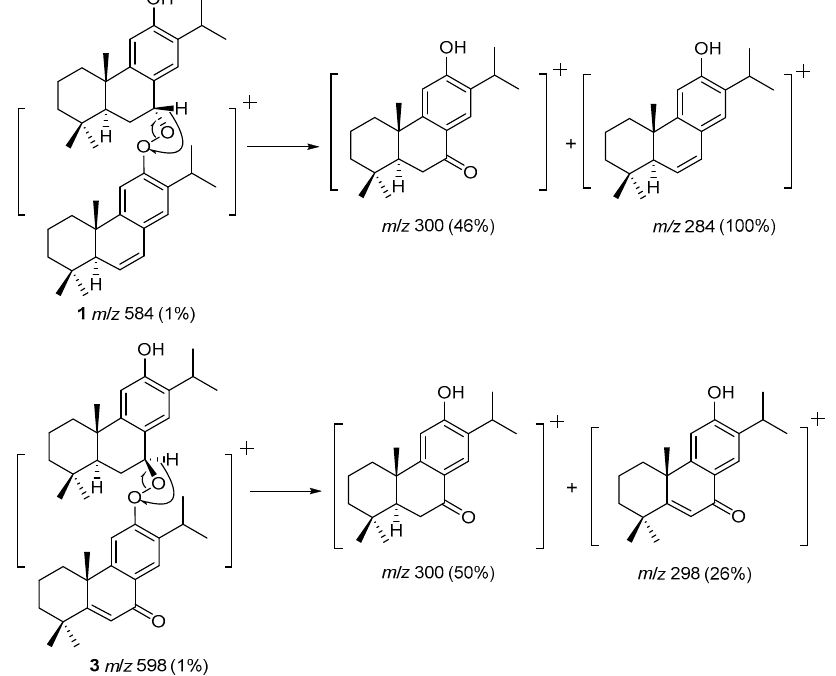
Figure 2. Some key electron impact (EI)-Mass fragmentations of compounds 1 and 3 .